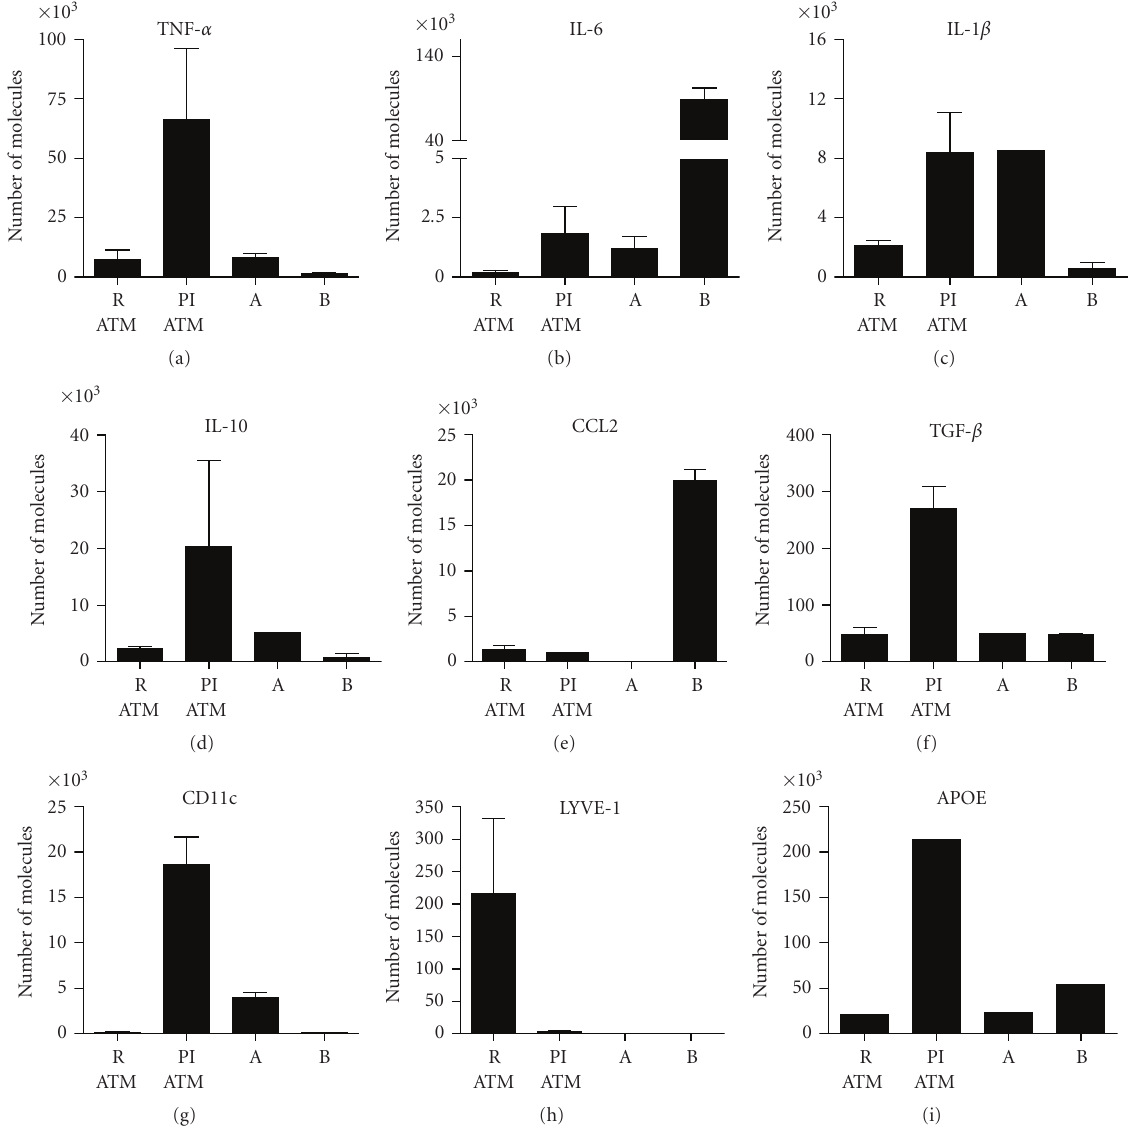
Figure 4: Pro-inflammatory ATMs express both pro- and anti-inflammatory mediators as assessed by gene expression. Four cell populations were sorted from the SVF from mice ( n ≥ 3) fed an HF/CH diet for approximately 16-weeks. The pro-inflammatory ATMs (PI-ATM: CD45+F480+CD11c+), resident ATMs (R-ATM: CD45+F480+CD11c − ), a CD45+ unknown population (A: CD45+F480 − CD11c+), and a CD45 − unknown population (B: CD45 Thy1.2+Ly6C+/ − CD11b − ) were sorted and analyzed for gene expression from two independent sorts.